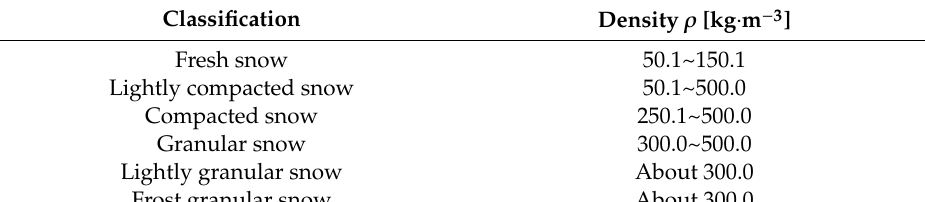
Figure 1. Rotating drum used in this study. An acrylic cylindrical container is set on a turntable.